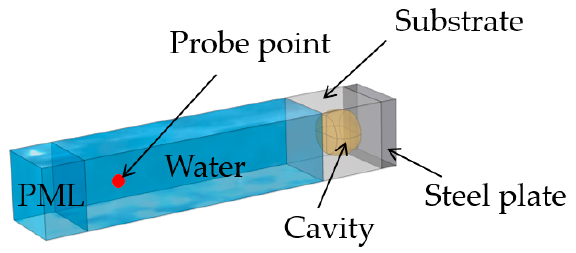
Figure 3. Cavity element model.